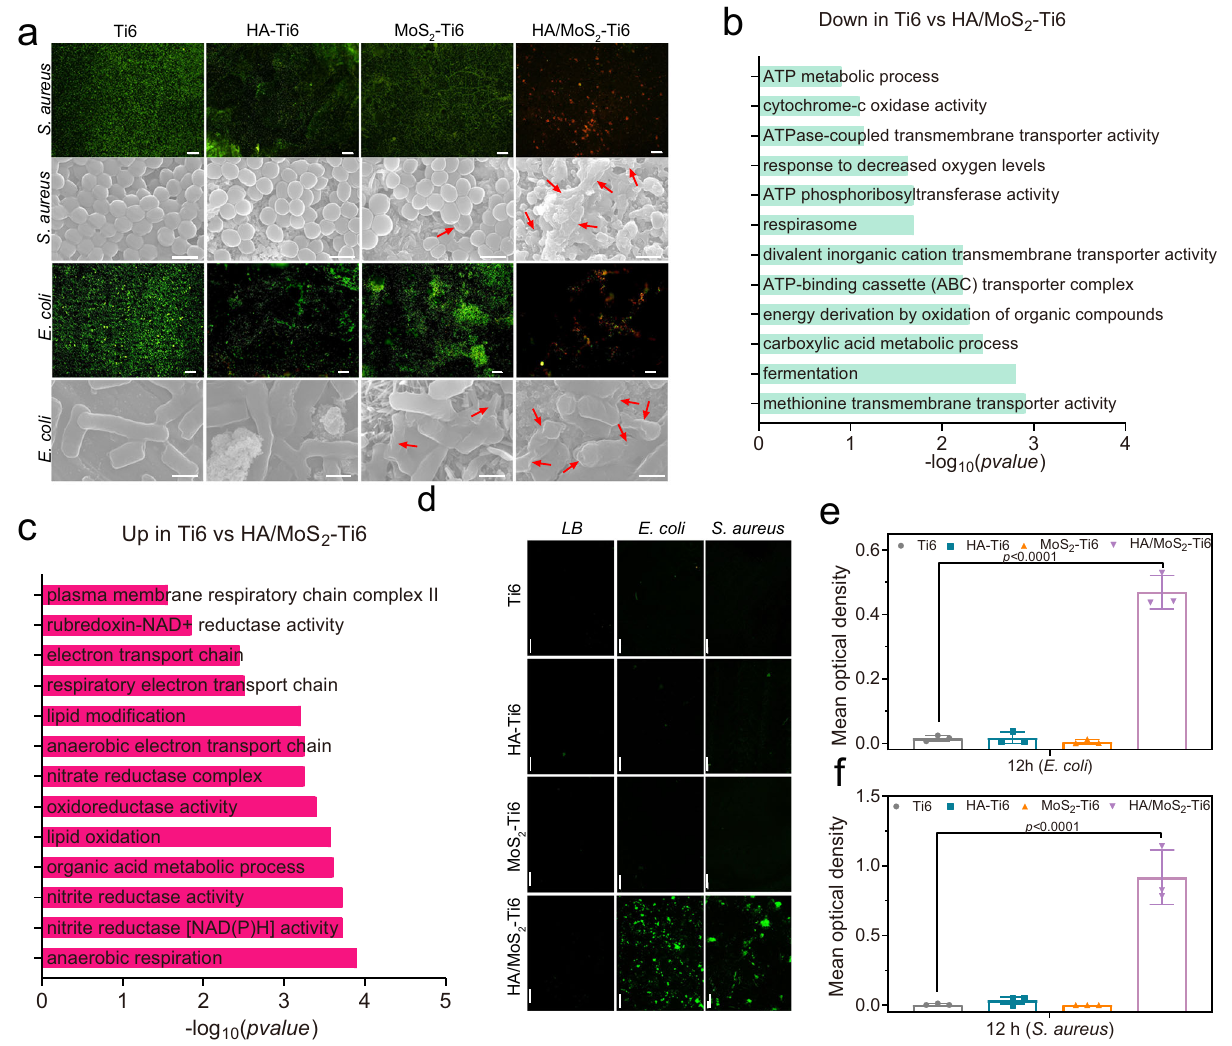
Fig. 3 Activation of bacterial death by HA/MoS 2 -Ti6. a Fluorescent images of stained bacteria (scale bar = 50 μ m) and FE-SEM morphologies (scale bar = 1 μ m) after treatment on various surface for S. aureus and E. coli . b Downregulated gene ontology (GO) enrichment analysis in HA/MoS 2 -Ti6 compared with Ti6. c Upregulated GO enrichment analysis in HA/MoS 2 -Ti6 compared with Ti6. d Detection of ROS production induced by different specimen of Ti6 HA – Ti6, MoS 2 -Ti6, and HA/MoS 2 -Ti6 (scale bar = 50 μ m). e , f Quantitative analysis of fl uorescent intensity. e , f Data represented as mean ± standard deviations from a representative experiment. Error bar represents the standard deviation. b , c , e , f p- values were generated by one-way ANOVA with Dunnett ’ s multiple comparison test. ( n = 3 independent samples). Source data are provided as a Source Data fi